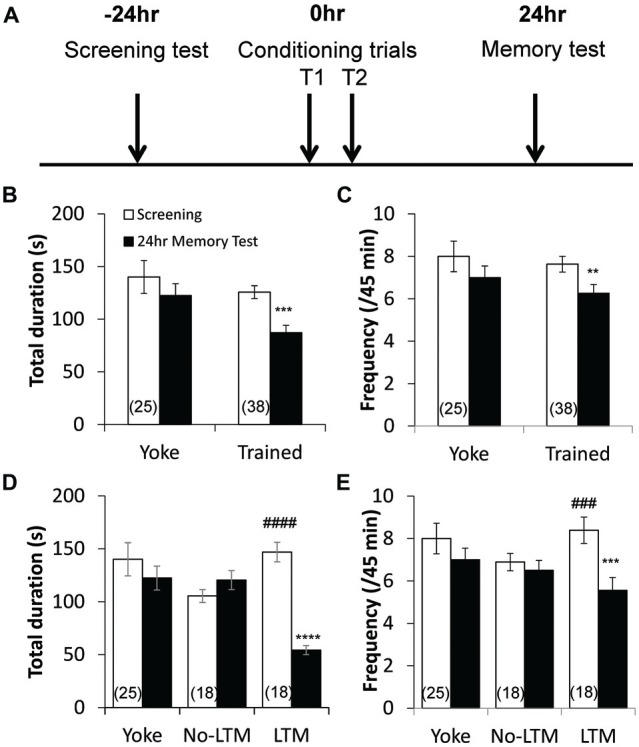
Aversive operant conditioning results in long-term memory (LTM) formation. (A) Time line of the conditioning paradigm. During the screening test, the frequency and total duration of pneumostome openings were observed over a 45 min period. Then, animals underwent two 45-min training sessions that were separated by an hour, during which trained animals received tactile stimuli contingent upon each attempted pneumostome opening and yoked controls received non-contingent stimuli. The frequency and total duration of pneumostome openings were observed again 24 h after conditioning during the memory test. Animals that underwent operant conditioning show significant reductions in both the total duration (B) and frequency (C) of pneumostome openings 24 h after conditioning as compared with the screening session, indicating LTM formation. No significant difference in either parameter is observed in yoked controls. In order to separate conditioned animals that do and do not form LTM, each animal was scored using the ratio of total duration of pneumostome opening at 24 h to those at screening (“D24/D0” ratio) to assess its behavioral response to the conditioning procedure. Animals that exhibit D24/D0 ratio <0.6 were classified as “LTM” and those with D24/D0 >0.8 were classified as “no-LTM”. Summary of total duration (D) and frequency (E) of pneumostome openings in yoked control, no-LTM and LTM animals before and after 24 h conditioning. Whereas LTM animals exhibit significant reductions in both the total duration and frequency of pneumostome openings at 24 h after conditioning, no-LTM animals did not. **p < 0.01, ***p < 0.001, ****p < 0.0001 as compared to screening test in LTM animals. ###p < 0.001, ####p < 0.0001 as compared to screening test in no-LTM animals.